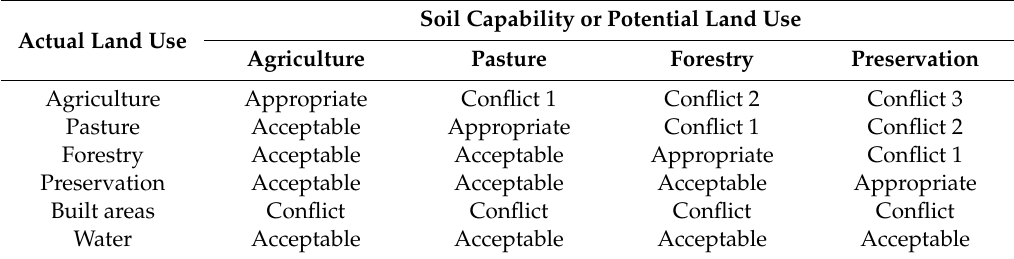
Table 6. Actual land use versus soil